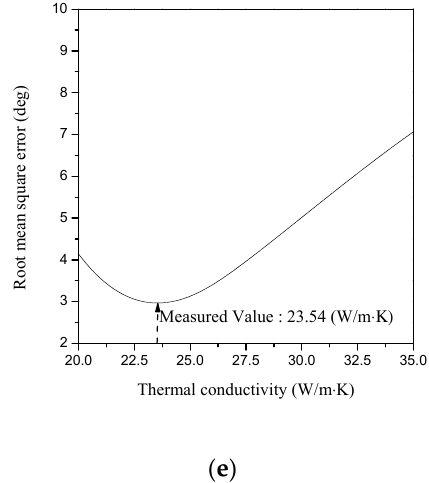
Figure 10. RMSE of thermal conductivity determination algorithm. ( a ) θ = 0 ◦ . ( b ) θ = 30 ◦ . ( c ) θ = 45 ◦ . ( d ) θ = 60 ◦ . ( e ) θ = 90 ◦ .